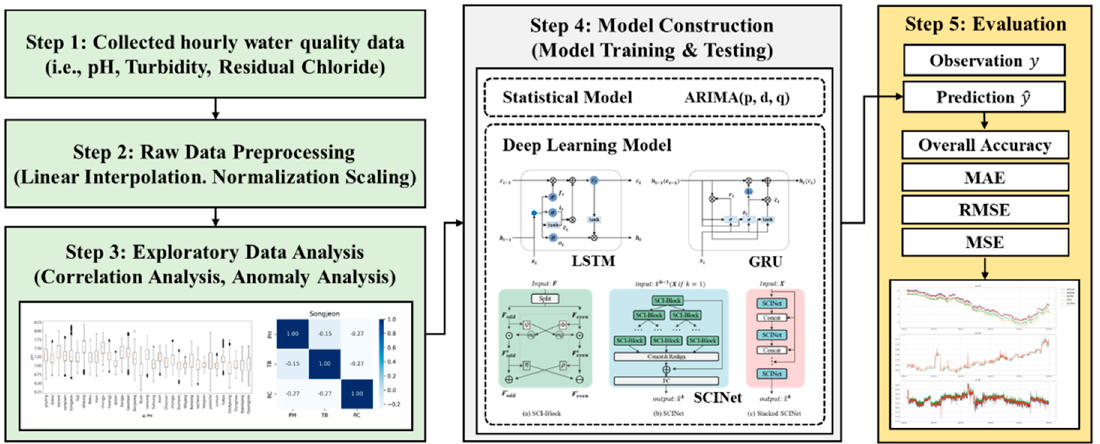
Figure 1. Proposed framework of the system.